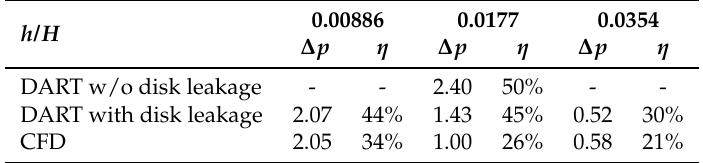
Table 2. Comparison between performance obtained using CFD and